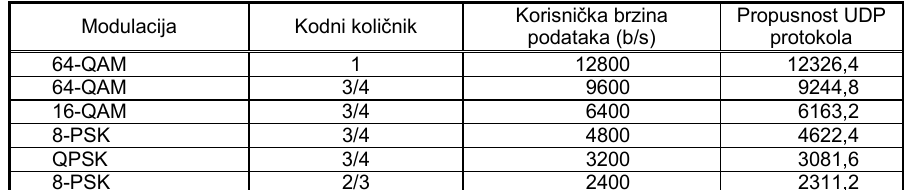
Table 2 – Impact of the modulation type and the error corection code on the UDP protocol